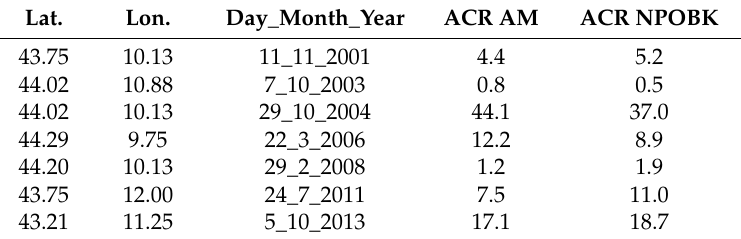
Table 2. Comparison of daily ACR estimates obtained by means of AM and NPOBK